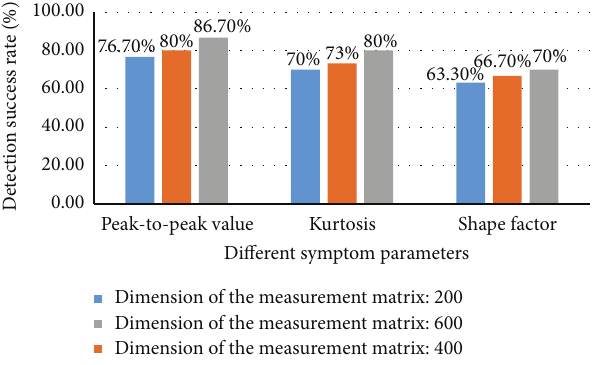
Figure 15: Dimension of the measurement matrix: 200, 400, and